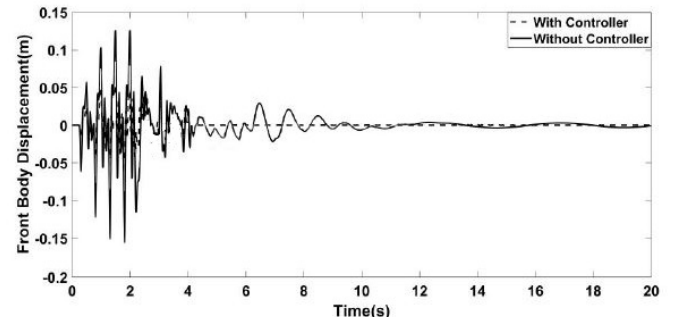
Figure 19. Front Body Displacement.